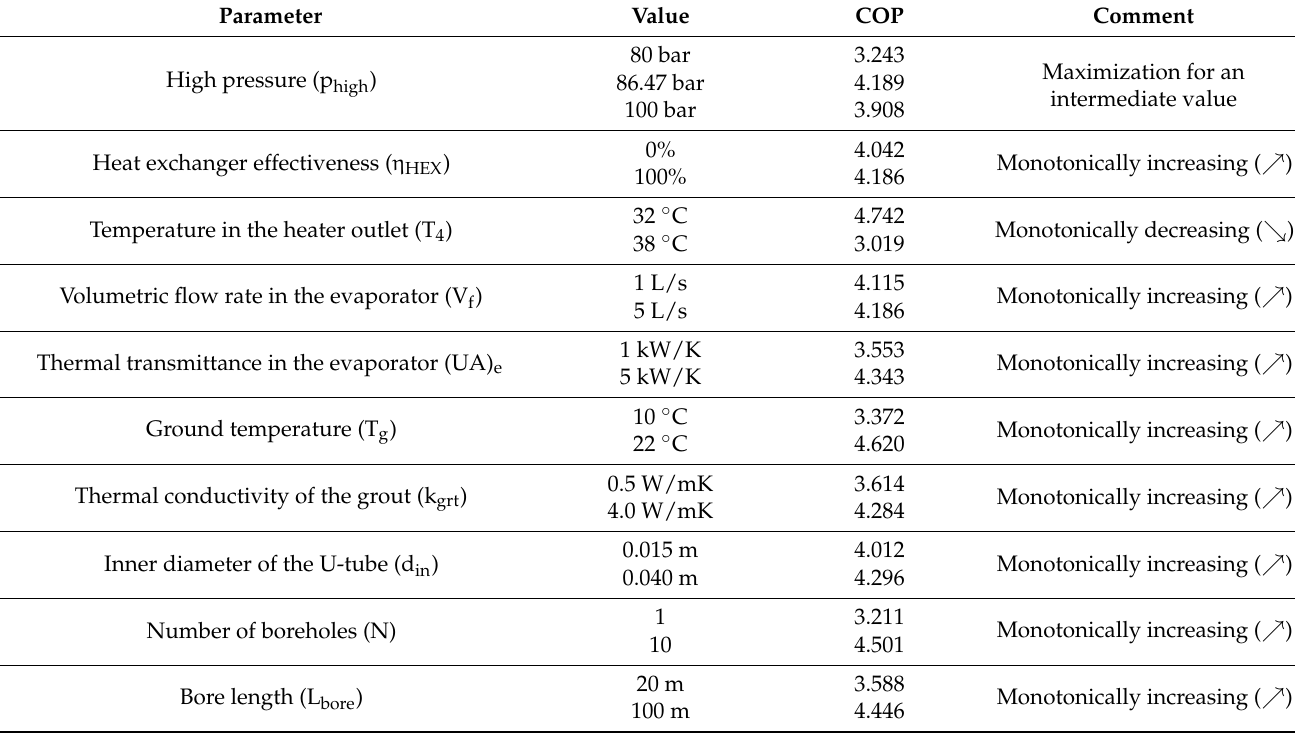
Table 5. COP analysis for the various parameters